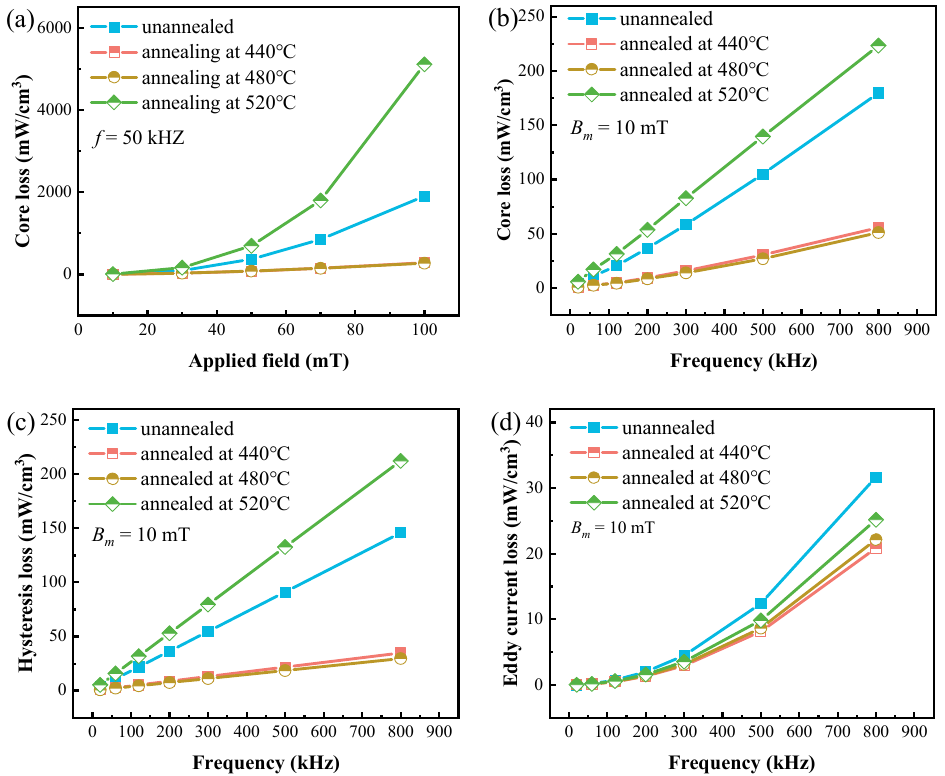
Figure 6. ( a ) Core loss versus induction of powder cores after annealing at different temperatures; ( b ) core loss versus frequency of powder cores before and after annealing at 440 ◦ C, 480 ◦ C and 520 ◦ C in 20–800 kHz, at 10 mT; ( c ) hysteresis loss at 10 mT; ( d ) eddy current loss at 10 mT.